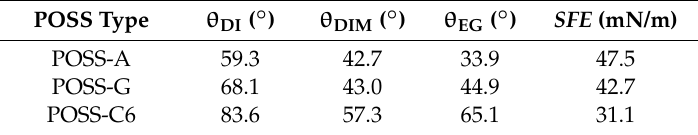
Table 1. Contact angle ( θ ) and surface free energy ( SFE ) of POSS-A, POSS-G, and POSS-C6.